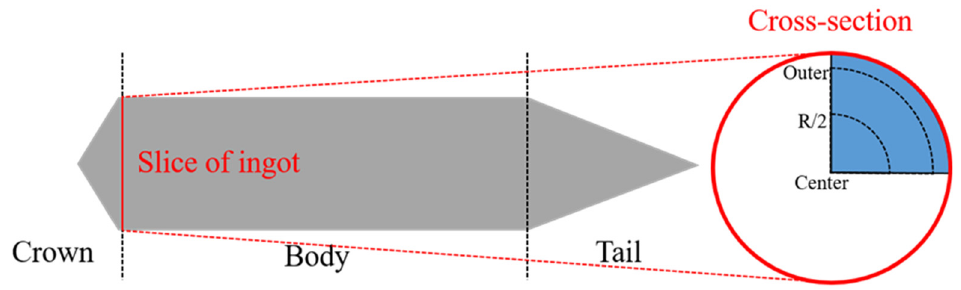
Figure 2. Schematic diagram of acquired samples from the ingot.